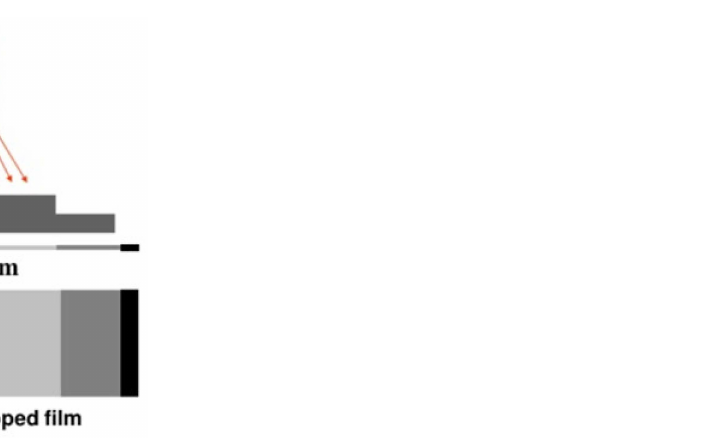
Figure 21. Example of radiographic testing of a defective component and its results gathered through the X-ray film [53].